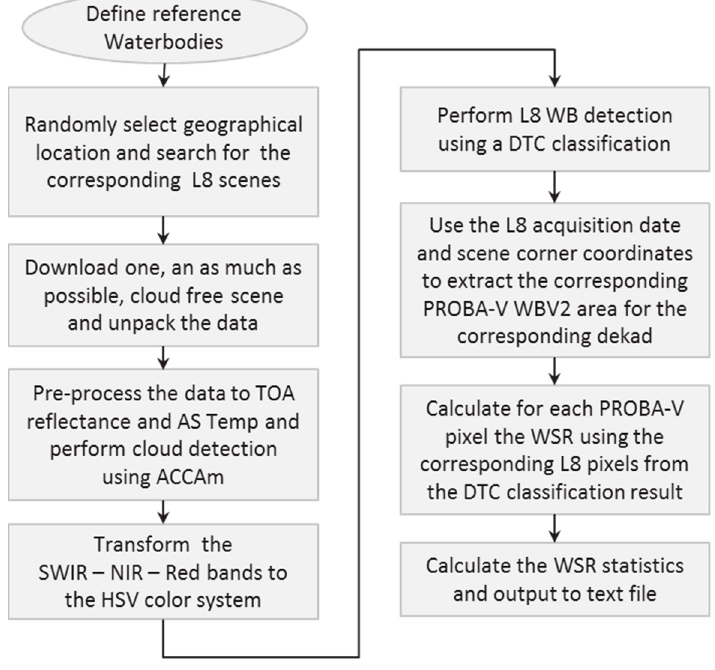
Figure C1. Workflow for the extraction and definition of reference water bodies using Landsat 8 scenes. TOA: Top Of Atmosphere; AS Temp: At satellite Brightness Temperature; ACCAm: Automatic Cloud Cover Assessment–modified.